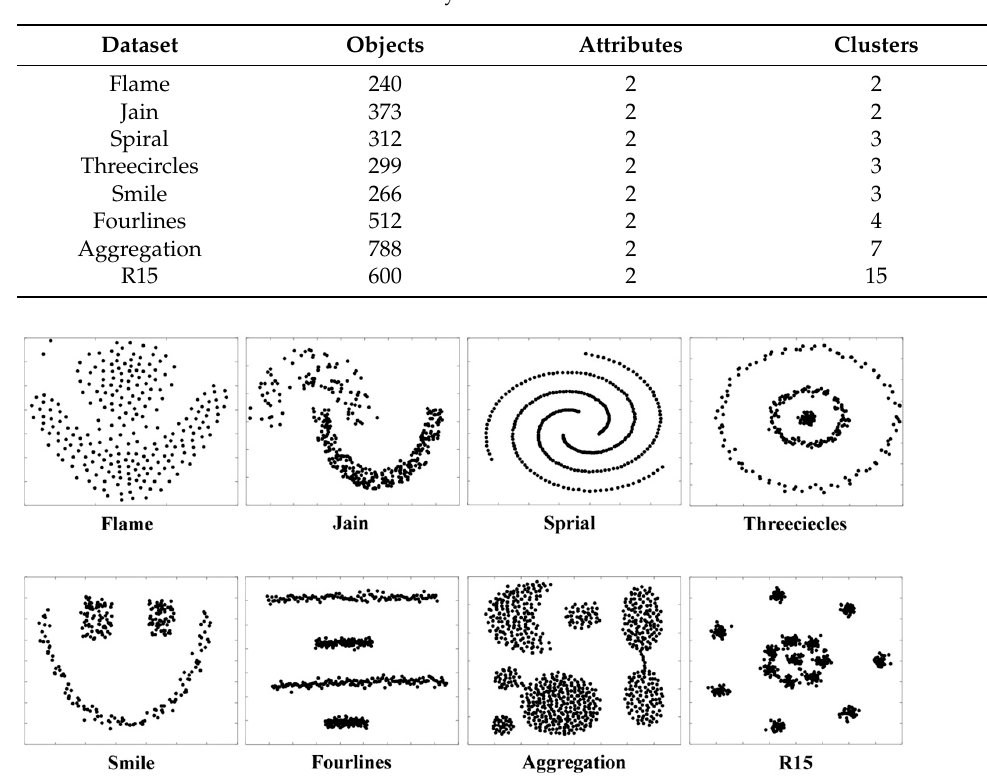
Table 3. The basic information of the nine synthetic datasets.